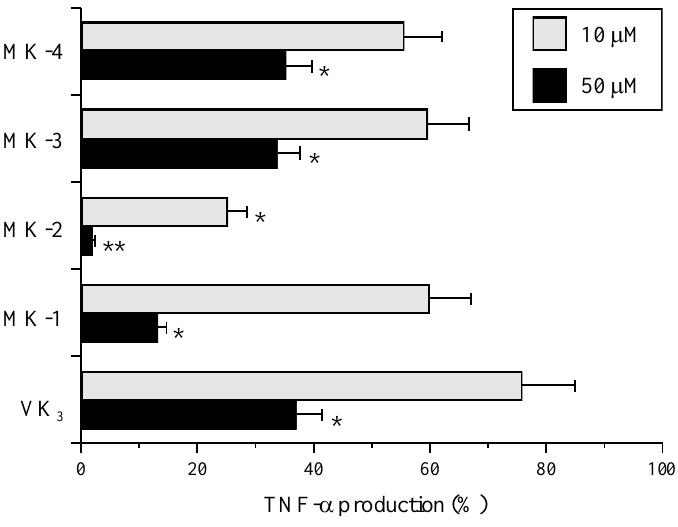
Figure 4. Inhibitory effects of the VK and VK intermediates on LPS-induced production 2 3 of TNF-α in the mouse macrophage cell line RAW264.7. These cells were pretreated with 10 and 50 κM of each compound as a vehicle control (TNF-α level, 52 pg/mL) for 30 min and then treated with 100 ng/mL LPS for 24 h (LPS-evoked TNF-α level, 448 pg/mL). The TNF-α concentration in the cell medium was measured by ELISA. The relative effect in the absence of the compound was taken as 100%. Data are shown as the mean ± SE ( n = 4). ** P < 0.01 and * P < 0.05 versus